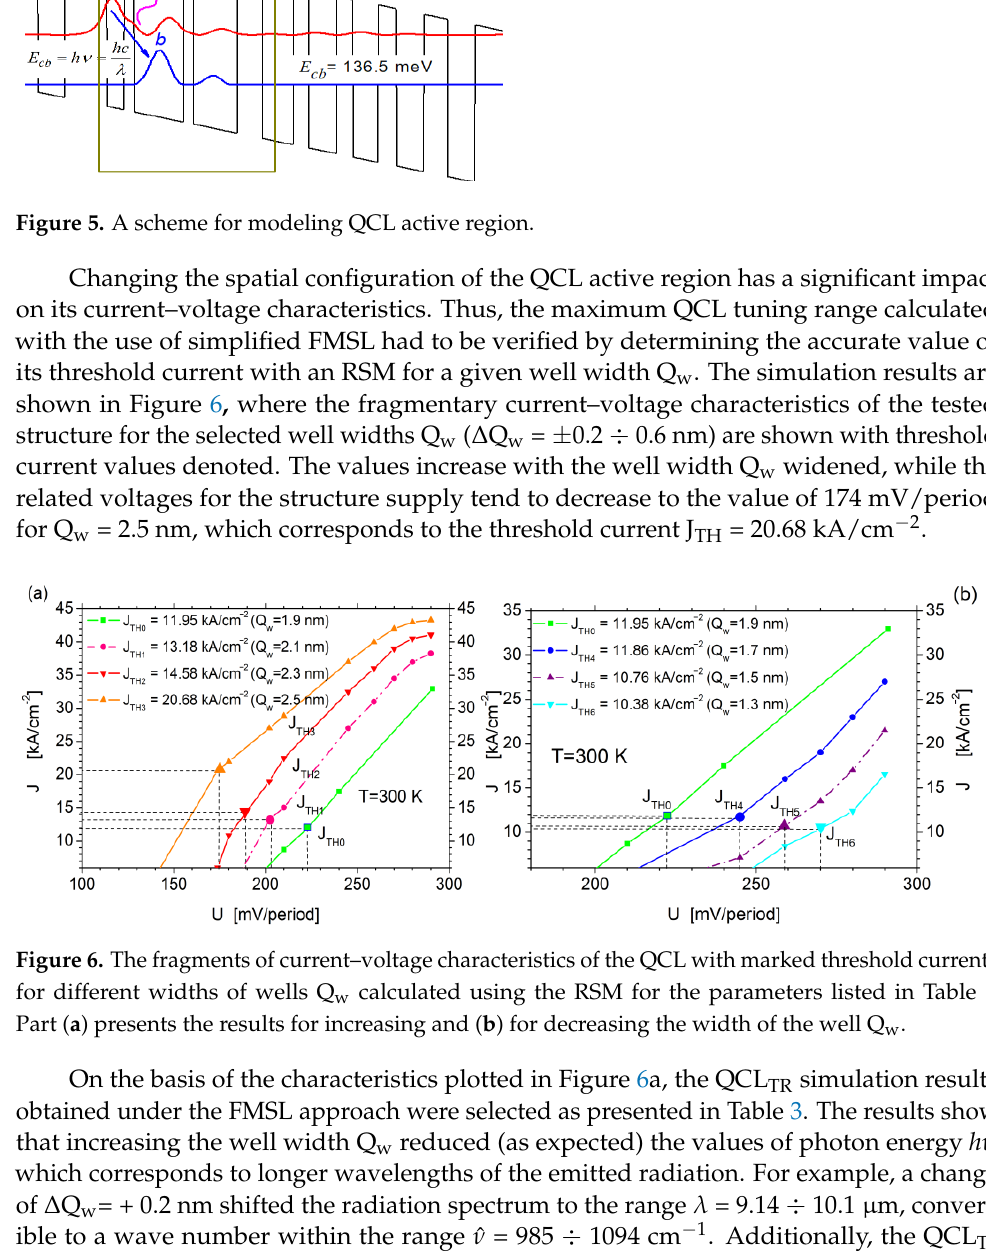
QCL T1 tuning range extended in relation to QCL TR0 , which was equal here to